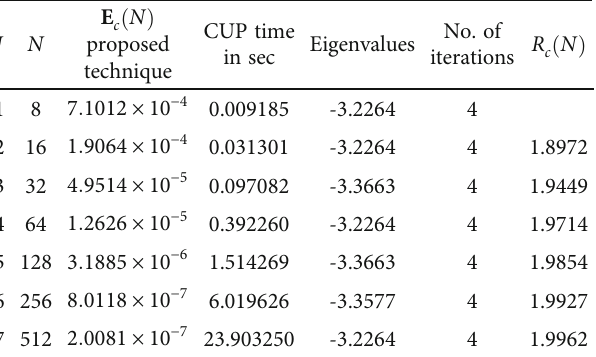
Table 2: Analysis of errors for Example